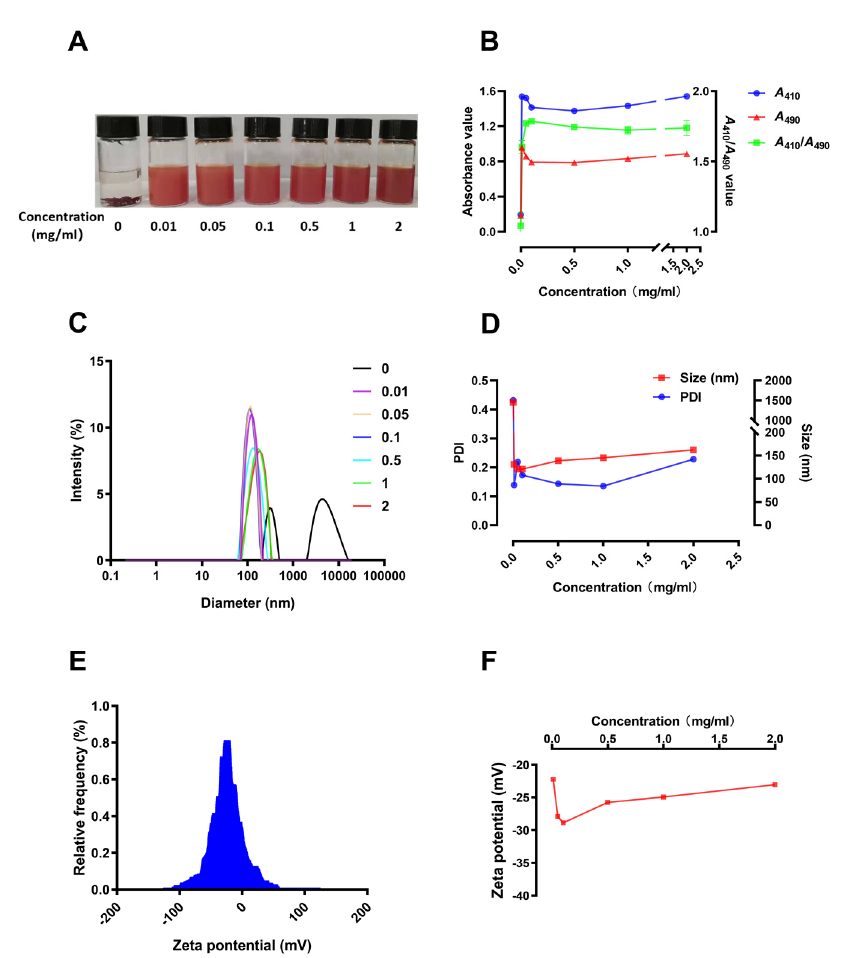
Figure 4. Optimization of SCP-Se NPs preparation process. ( A ) The appearance of SCP-Se NPs modified with different concentrations of SCP. ( B ) The A410, A490, and A410/A490 values of SCP-Se NPs solution at different SCP concentrations. ( C ) The particle size distribution of SCP-Se NPs at different SCP concentrations. ( D ) The median particle size and PDI of SCP-Se NPs at different SCP concentrations. ( E ) Zeta potential of SCP solution. ( F ) Zeta potential of SCP-Se NPs at different SCP